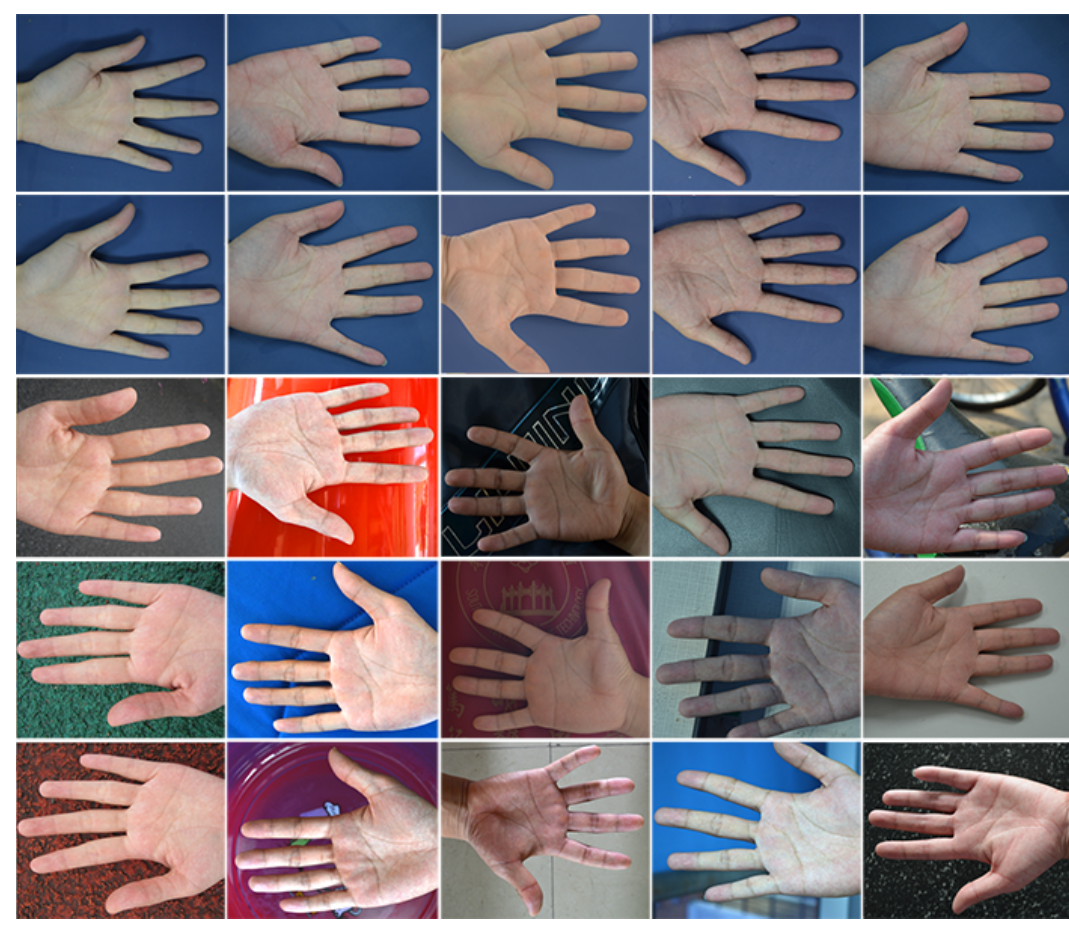
Figure 10. Samples in our IKP database. Each column corresponds to one